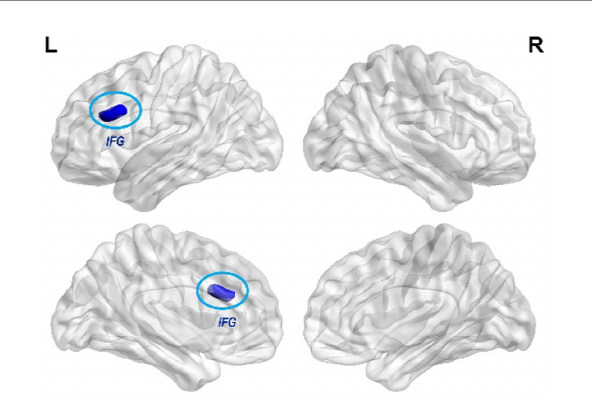
FIGURE 2 Changes of LC FC in the RA group compared with baseline. The blue color indicates the LC -left IFG FC is decreased in RA after treatment. (GRF correction, p -voxel < 0.001, p -cluster < 0.05, cluster size >